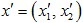
Majorization-Minimization by IST and DG-IST.(A) the J(x) function to be minimized. (B) The G(x) (yellow surface) function where G(x) ≥ J(x) ∀ x and G(xk) = J(xk), IST algorithm. (C) G(x) ≥ J(x) ∀ x2 with x
1 = const and G(xk) = J(xk), DG-IST algorithm. (D) xk is the initialization point of vector x (black arrow) and blue arrow indicates the x′=(x′1,x′2) where G(x) is minimized, IST algorithm. (E) xk is the initialization point of vector x (black arrow, same as in (D)) and blue arrow indicates the x″=(x″1,x″2) where G(x) is minimized, DG-IST algorithm. Notice that, x″2<x′2, thus closer to the point where J(x) is minimized (see (A)).